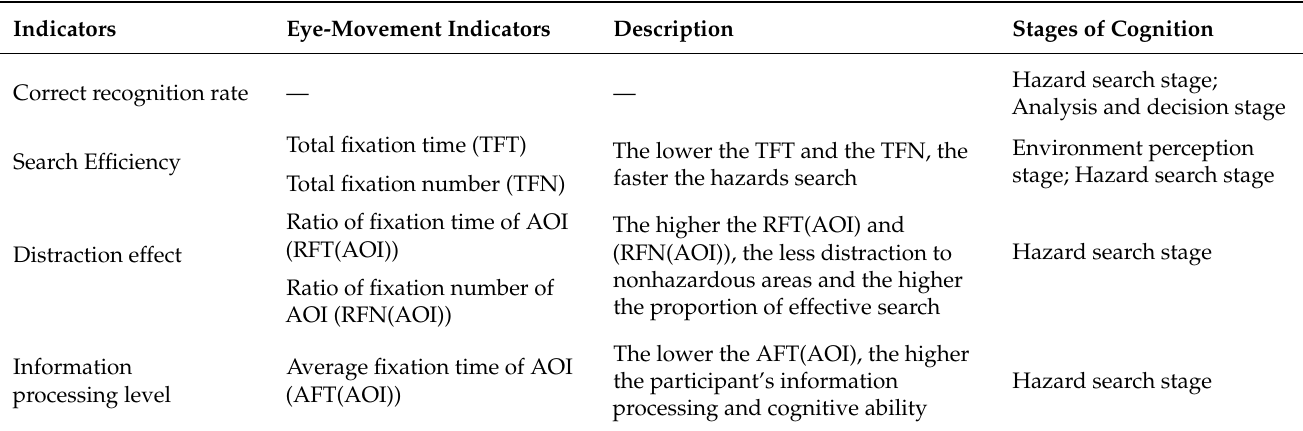
Table 1. Performance evaluation index for identification of